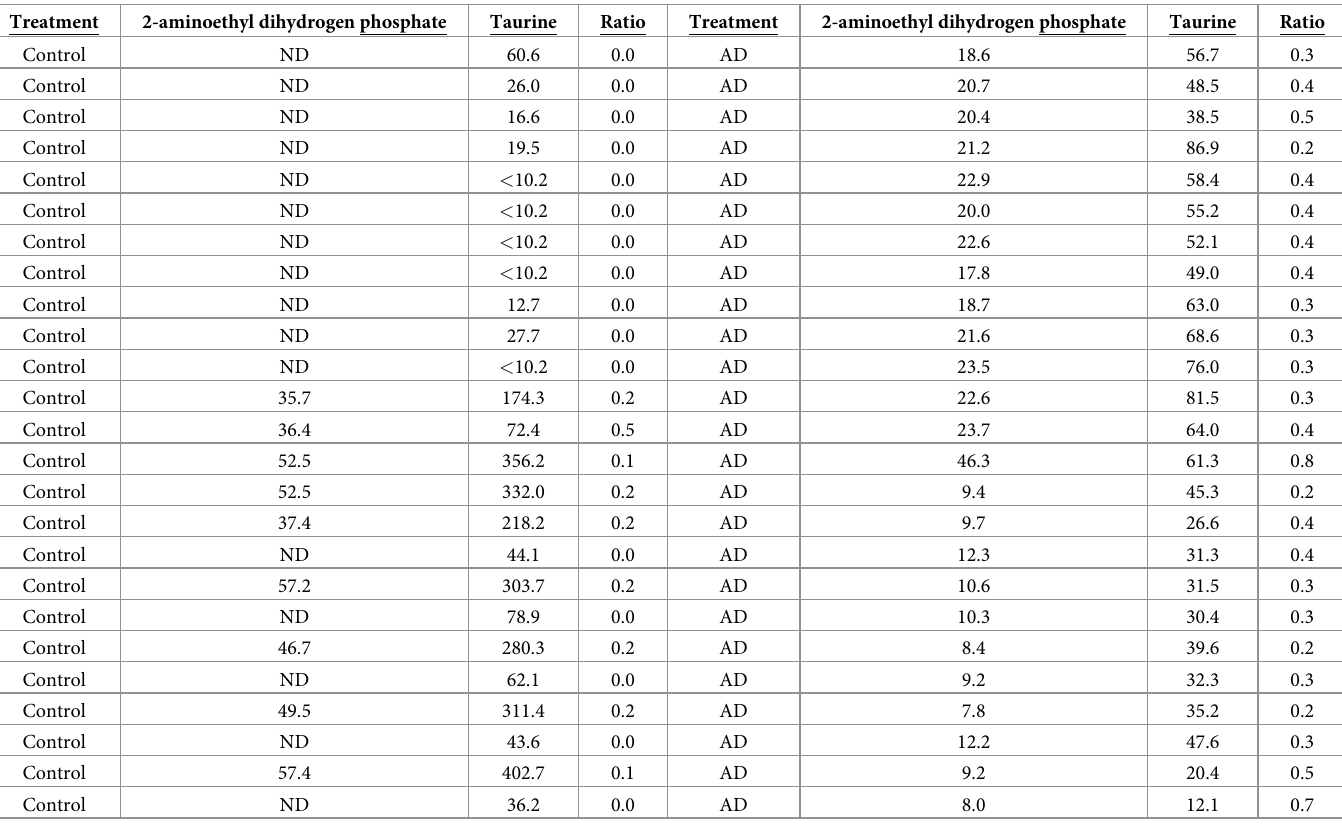
Table 1. Concentration ( μ moles/L) of 2-aminoethyl dihydrogen phosphate and taurine in blood plasma of controls and Alzheimer’s patients calculated using the Amino Acid Analyzer method. The lower limit of detection (LOD) for 2-aminoethyl dihydrogen phosphate using this method was 0.9 μ mol/L. The lower limit of quanti- fication (LOQ) for taurine was 10.2 μ mol/L. This represents a detectable peak but one below the ability of the method to accurately quantify. When 2-aminoethyl dihydro- gen phosphate was not-detectable (ND), ratios were assigned a 0.0